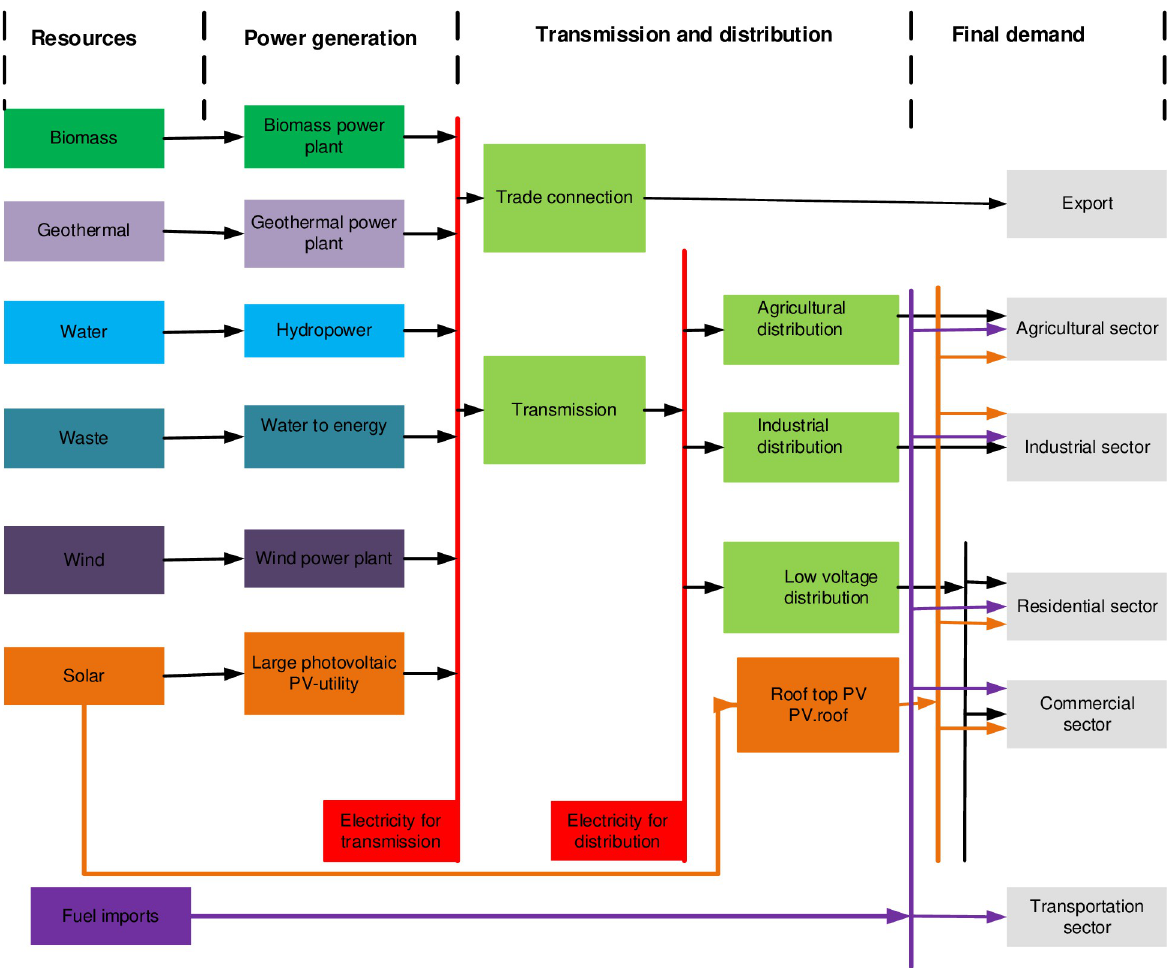
Fig 1. Simplified Reference Energy System (RES) of